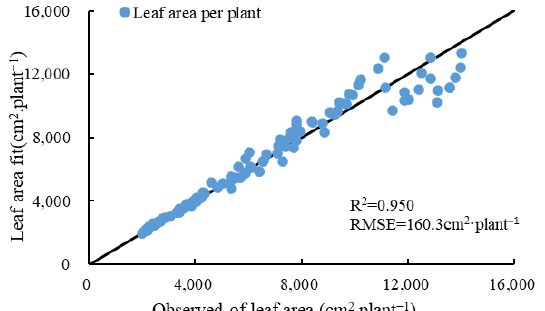
Figure 14. Comparison of observed and simulated values of leaf area fit under LT and PL stresses.